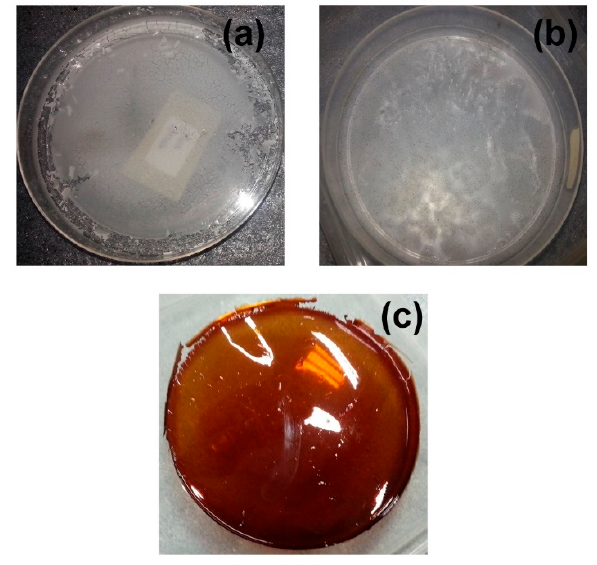
Figure 1. Photographs of ( a ) pure starch film, ( b ) starch film with 15 wt.% glycerol, and ( c ) SRF60-1.